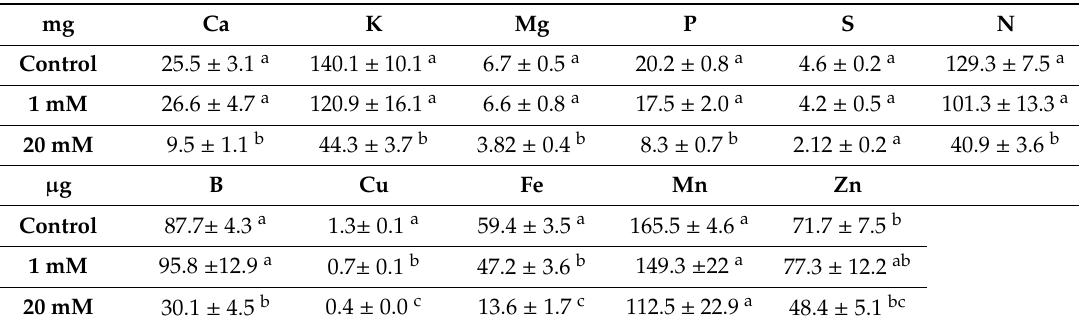
Table 5. Shoot fresh weight, shoot dry weight and root dry weight mean values of lettuce plants grown aeroponically. Experiments 4–7. Data are means ± SE of 8 replicates. Asterisks indicate significant differences between treatments (* p < 0.05; ** p < 0.001).